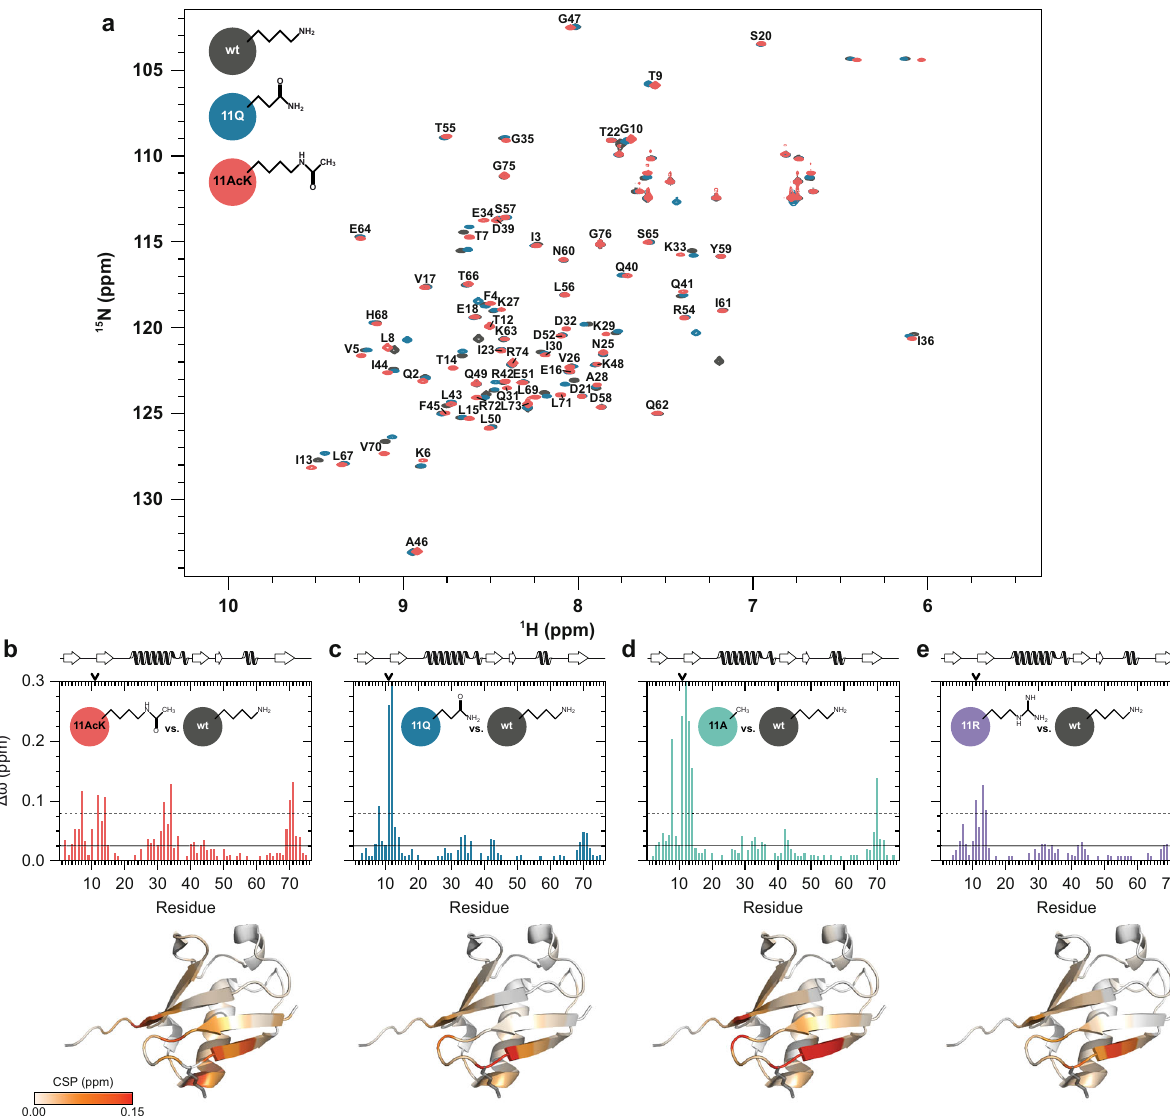
Fig. 3 | Ub11AcK and Ub 11Q are structurally different.a Superimposition of the two-dimensional heteronuclear 1 H – 15 N HSQC NMR spectra of Ub 11AcK (red), Ub 11Q (blue) and nonmodi fi ed Ub (wt, gray), each with the respective side chain indicated. The labeling of the backbone amide resonances by the one letter code corresponds to the spectrum of Ub 11AcK. b – e Weighted chemical shift perturba- tion(CSP, Δω )mappingsareshownforUb11AcK( b ),Ub11Q( c ),Ub11A( d ),andUb 11R ( e )versusnonmodi fi ed Ub(wt).Thecutoffvaluesarethesameforallplotsand were calculated by taking the mean (horizontal solid line) and the mean plus one standard deviation (horizontal dashed line), respectively, over all Δω values from